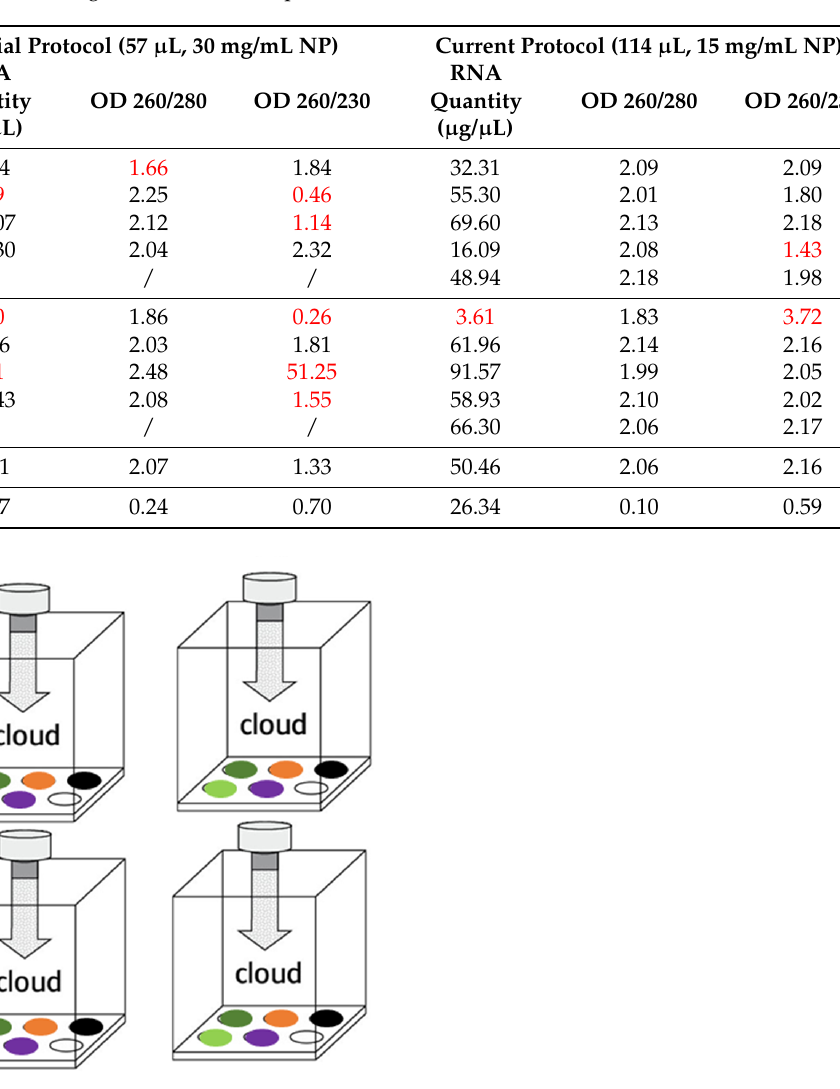
Table 2. Quality and quantity of RNA extracted from NR8383 cells exposed to TiO 2 NP through nebulization following the initial or current protocol. Results in red indicate a poor RNA quality or quantity preventing the use of the sample.